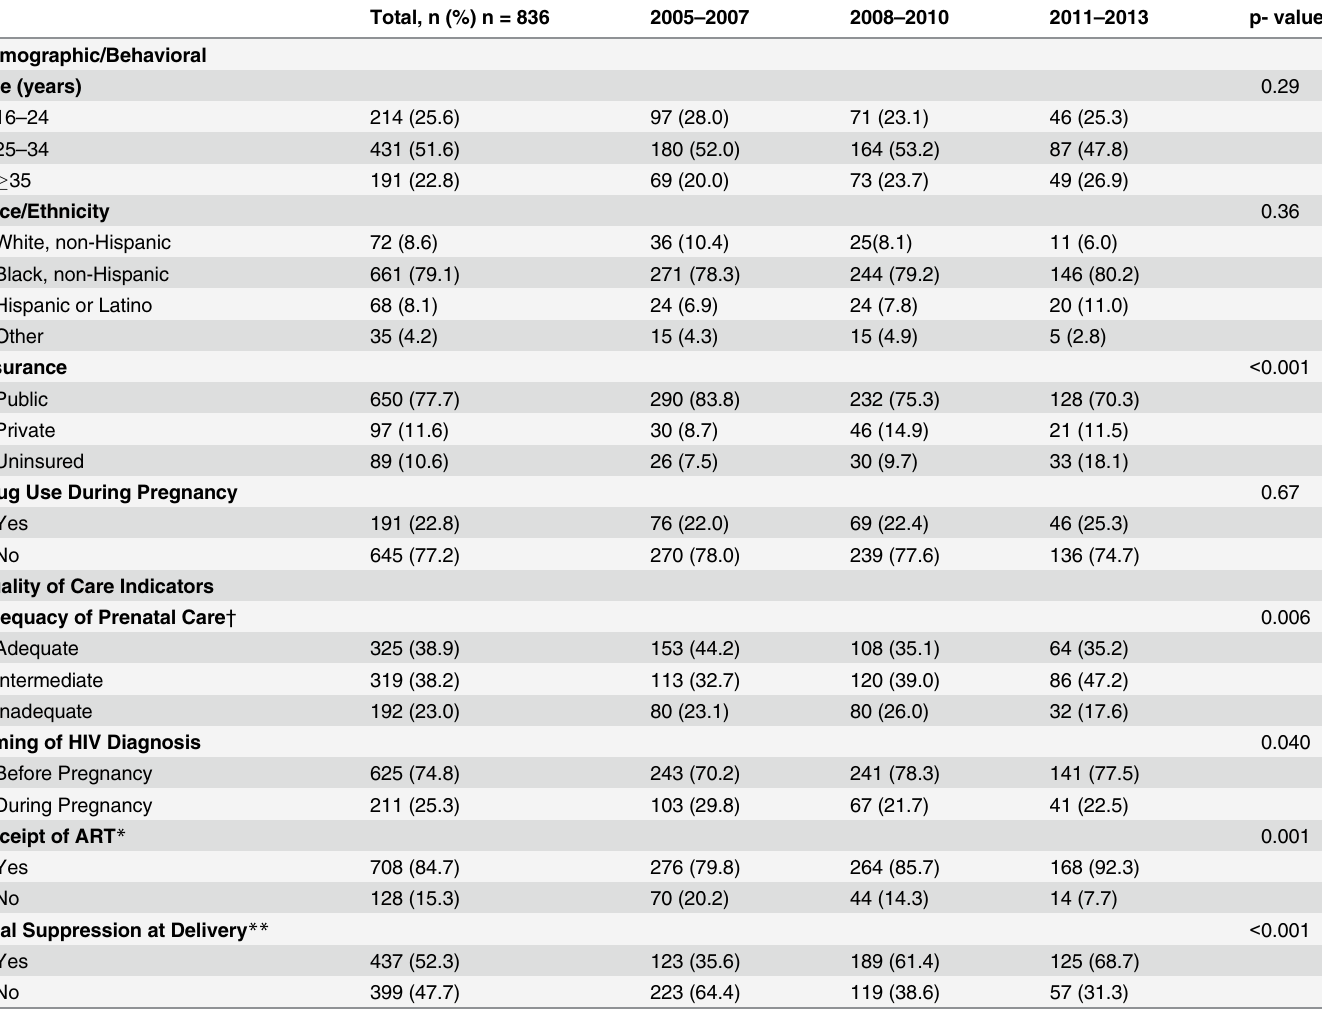
Table 1. Demographic, Behavioral and Quality of Care Indicators among Pregnant Women Infected with HIV, Enhanced Perinatal Surveillance Project, Philadelphia, 2005 – 2013. Total, n (%) n =